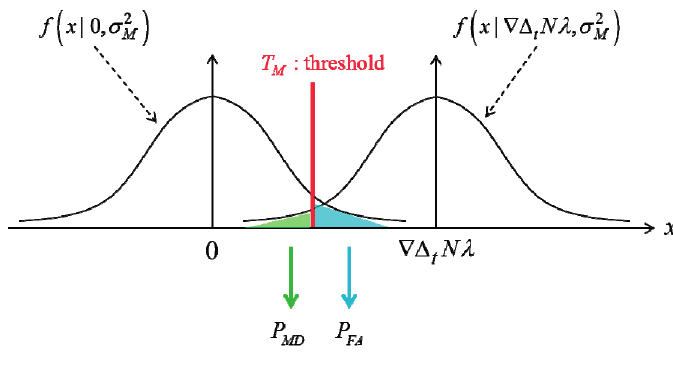
Figure 4. Monitoring value probability distribution